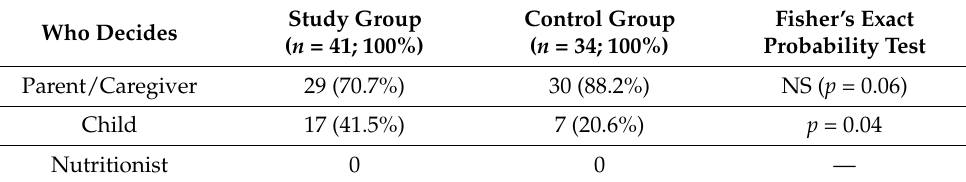
Table 11. Who decides about the selection of foods consumed by the children in the Study Group and the Control Group (question